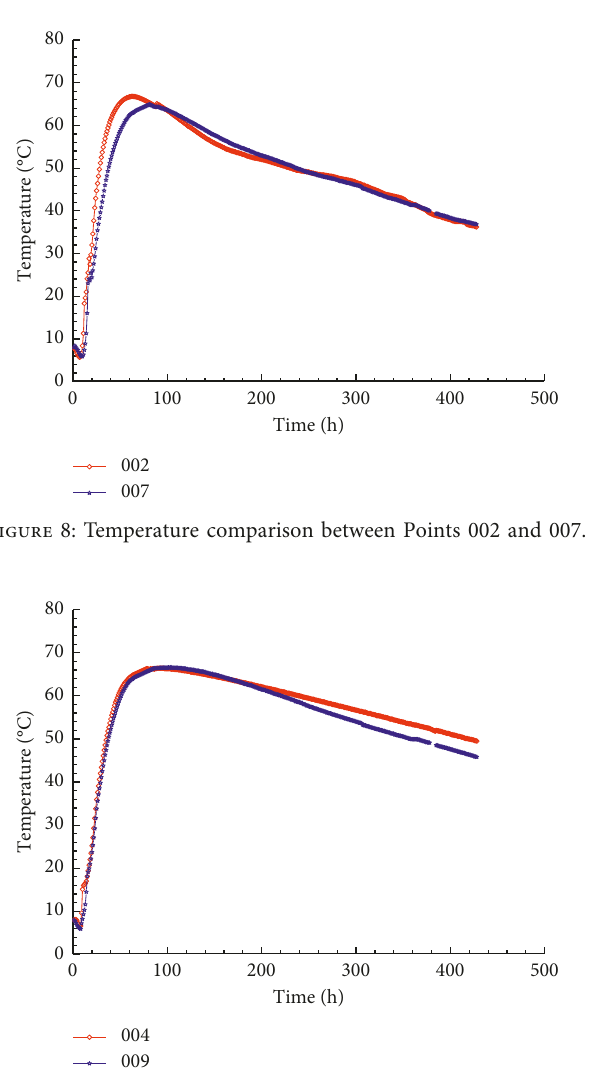
Figure 9: Temperature comparison between Points 004 and